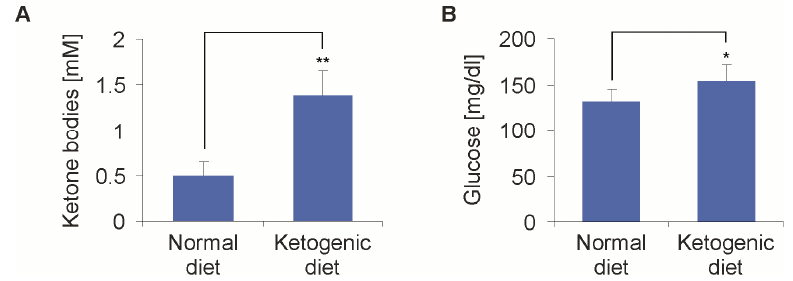
Figure 3. Effects of a ketogenic diet (KD) on blood ketone bodies and glucose levels. Mice were fed either a normal diet or ketogenic diet. ( A ) After one week, the blood ketone bodies showed an average of 1.38 ± 0.28 mmol/L in the KD group compared to 0.5 ± 0.14 mmol/L in the standard diet (SD) group ( n = 8, mean + standard deviation, ** p < 0.01, Student’s t -test). ( B ) At the same time, the blood glucose was higher in the KD than in the SD group (153 ± 18 mg/dL vs. 131 ± 14 mg/dL, n = 8, mean + standard deviation, * p = 0.03, Student’s t -test). The measurement of the baseline blood glucose in the further course of time course of time never showed a difference in the blood glucose between the two groups again. never showed a difference in the blood glucose between the two groups